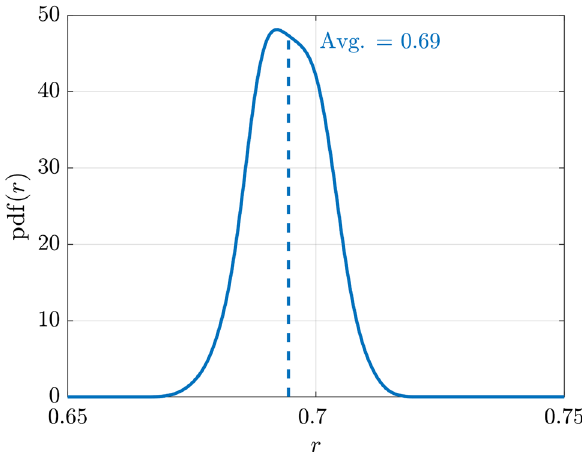
Figure 7. Probability density functions over 100 experiments of the correlations between the average group cooperation X G and the IPC dataset α centered on the average correlation.